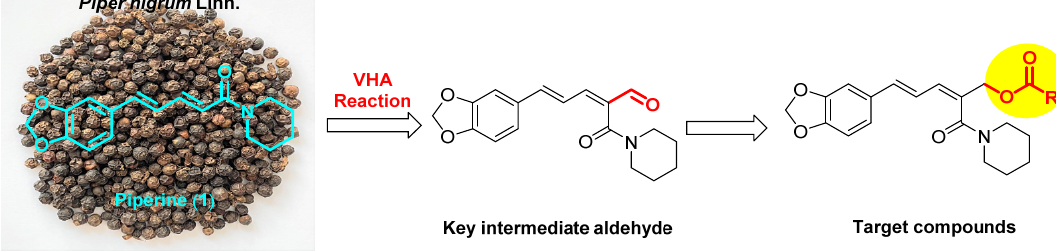
Figure 1. Design of target compounds from piperine ( 1 ) via the VHA reaction.